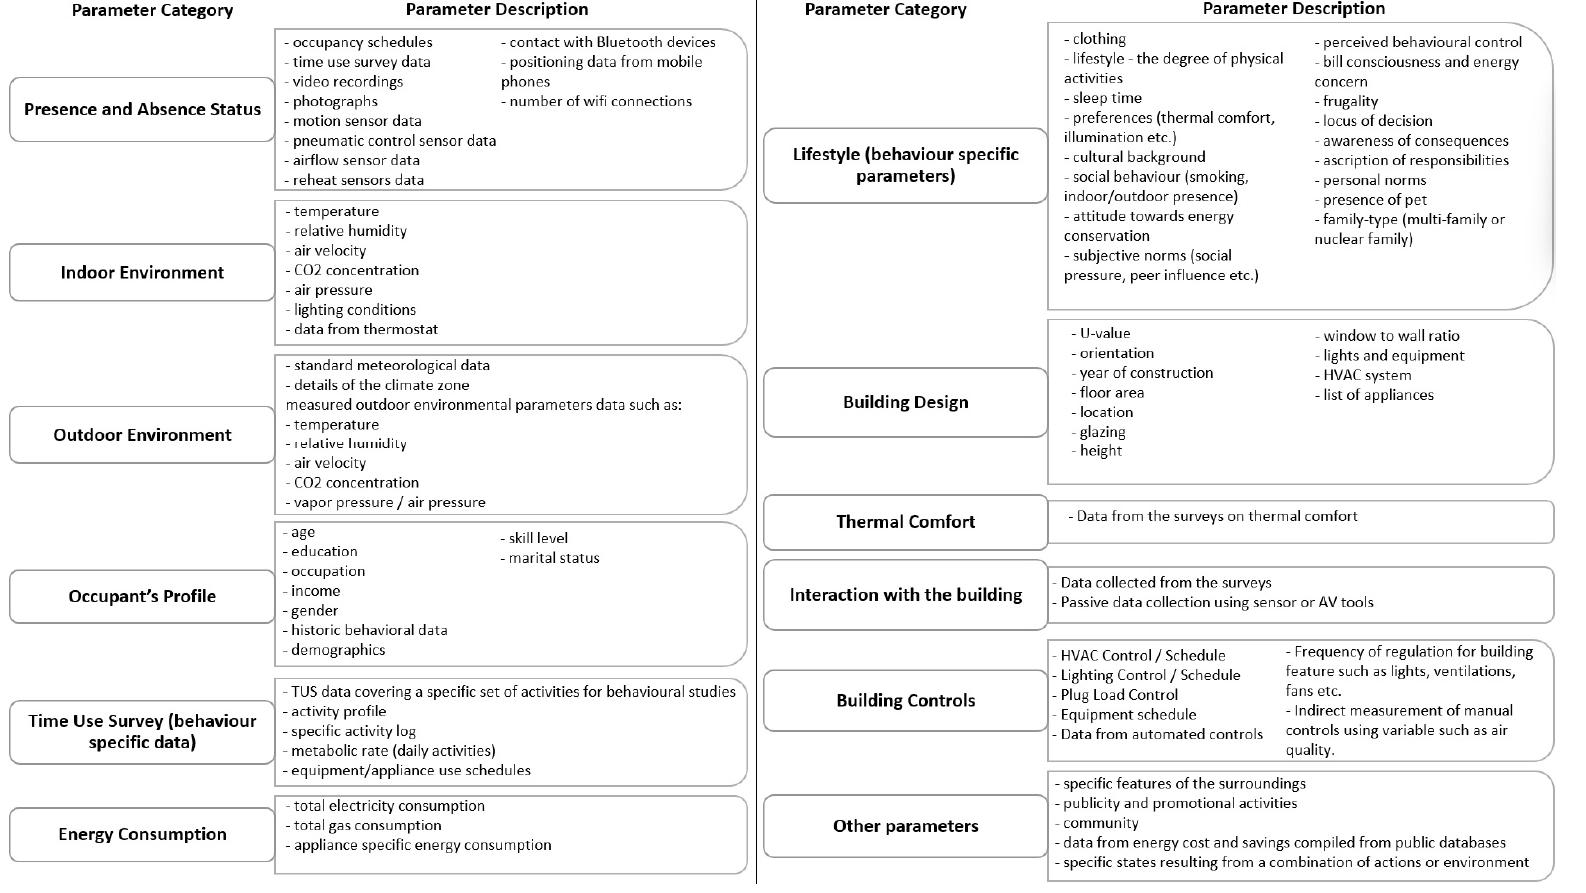
Figure A1. Categorisation of Parameters Used in Different Modelling Techniques.